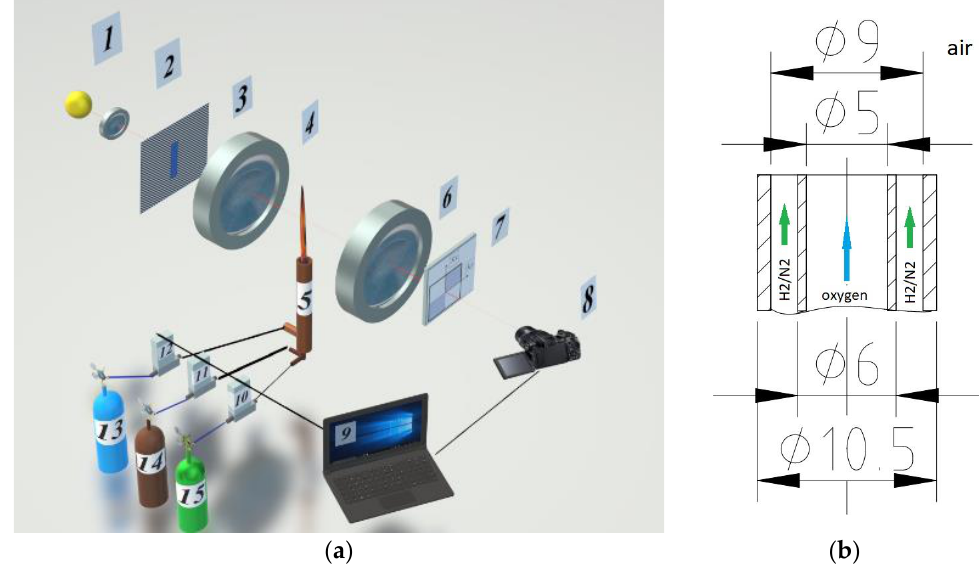
Figure 1. Experimental research setup. ( a ) optical scheme; ( b ) geometry of the burner